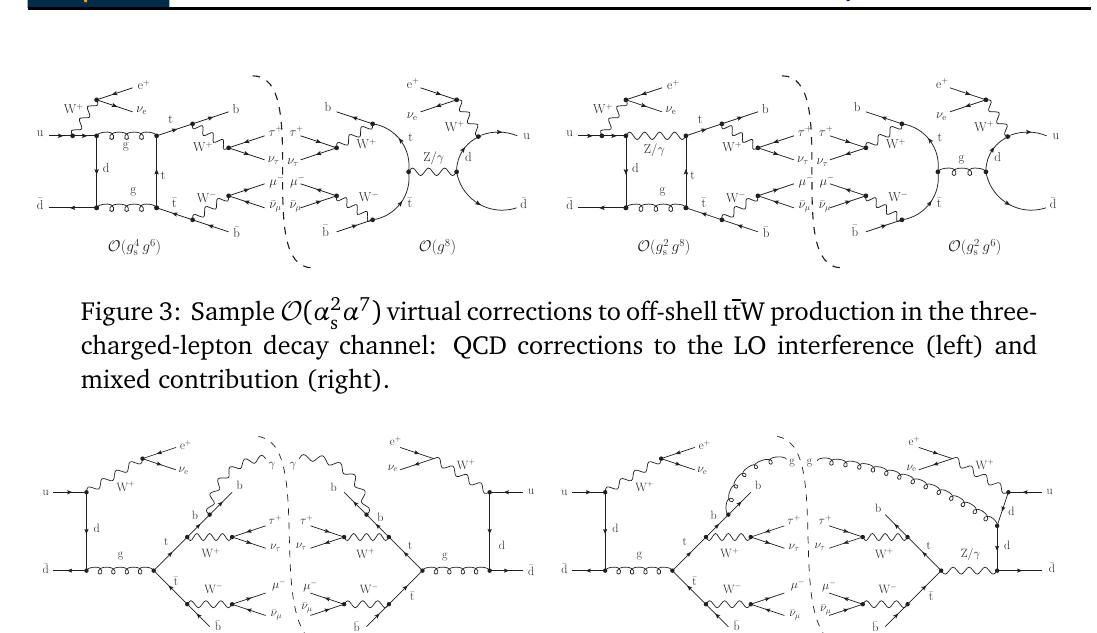
(left) and QCD corrections QCD